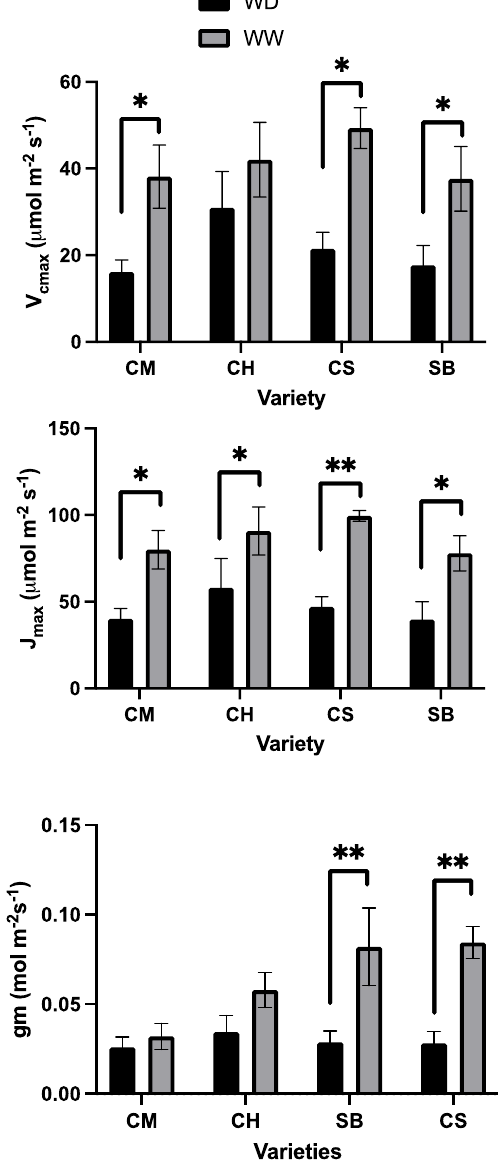
Figure 10. Maximum capacity for carboxylation (Vcmax, upper panel), maximum capacity for electron transport (Jmax, middle panel) and mesophyll conductance (gm, lower panel) for Carmenere (CM), Chardonnay (CH), Sauvignon blanc (SB) and Cabernet sauvignon (CS) in WD (black) and WW (grey). Error bars represent SE. Single asterisk represents significant differences between treatments for each variety p ≤ 0.05. Double asterisk represents significant differences between treatments for each variety p ≤